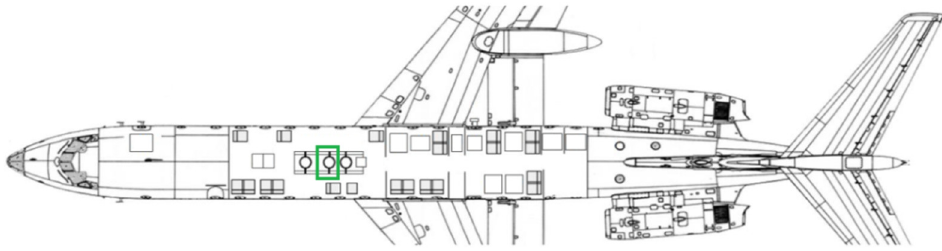
Figure 7. Place of the mobile lidar (green rectangle) onboard the TU-134 “Optik” aircraft laboratory. The lidar worked from an AC line (220 V, (50 ± 1) Hz) and was connected to a DC line (24 V) through a voltage converter. Before the use of the lidar, it was necessary